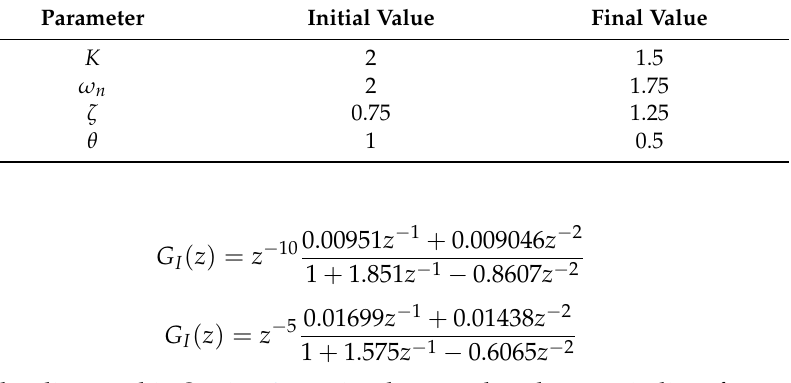
Table 1. Parameters and configuration of the time-varying system.